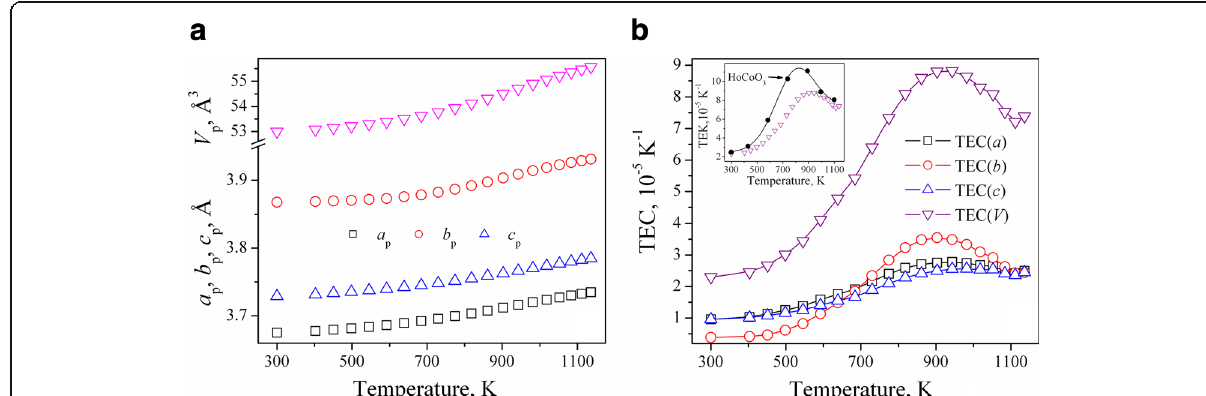
Fig. 3 Temperature evolution of the normalized unit cell parameters ( a ) and linear thermal expansion coefficients ( b ) of HoCo 0.5 Cr 0.5 O 3 . The orthorhombic lattice parameters are normalized to the perovskite cell as follows: a p = a o / √ 2, b p = b o / √ 2, c p = c o /2, V p = V o /4. The values on linear TECs in three crystallographic directions as well volumetric TEC were obtained by differentiation of experimental unit cell dimensions on the temperature. Inset on the right panel shows volumetric TEC of HoCo 0.5 Cr 0.5 O 3 in comparison with literature data for HoCoO 3